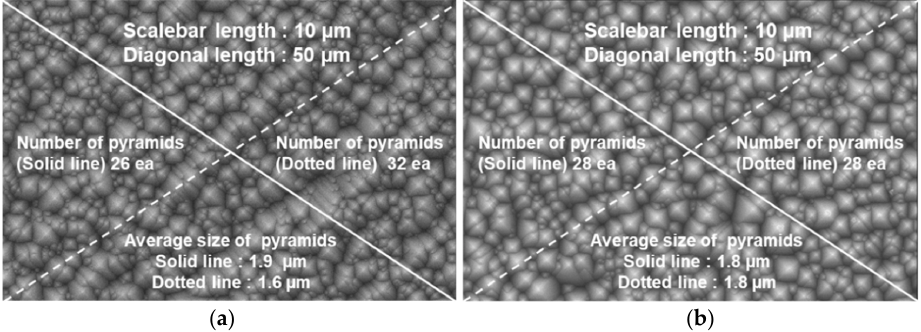
Figure 4. Intercept method using SEM image: ( a ) without thermal treatment; ( b ) with thermal treatment after texturing.